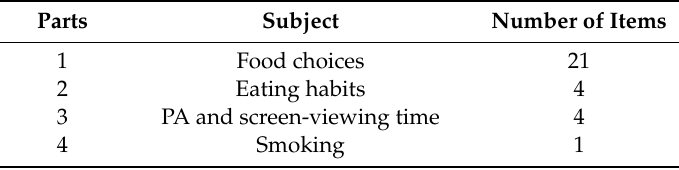
Table A2. Structure of the dietary adherence